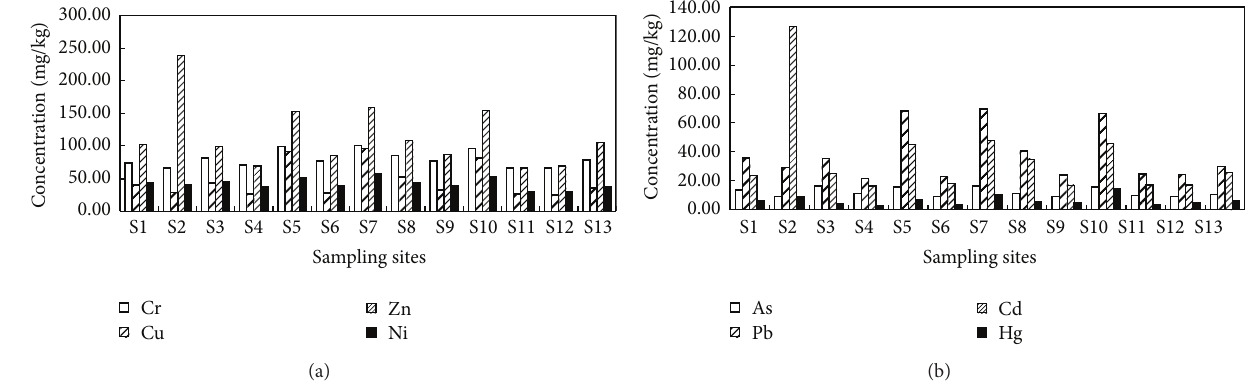
Figure 2: Spatial distribution of heavy metals in sediments from TGR tributaries.